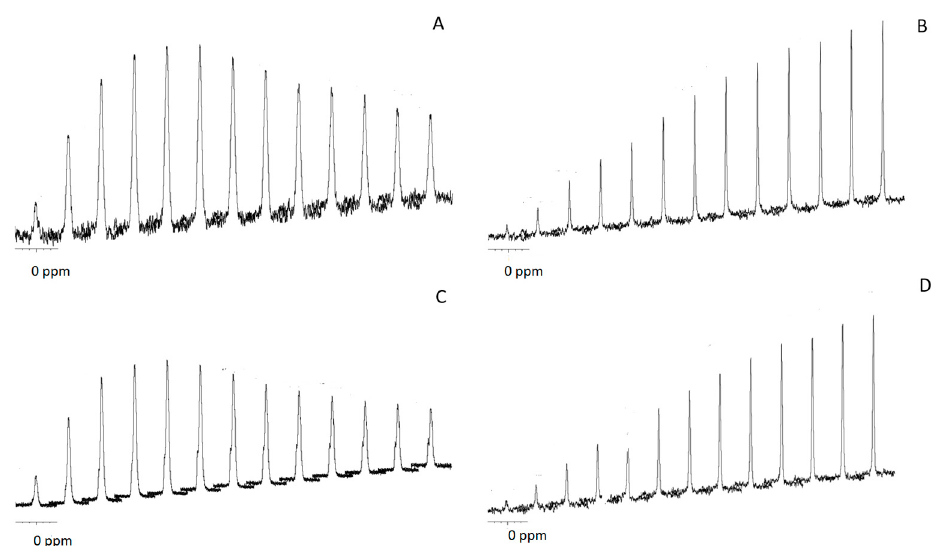
Figure 5. Array of CP spectra at different contact times for CSCaP1 ( A ); CSCaP1C ( B ); CSCaP3 ( C ) and CSCaP3C ( D ). From left to right contact times: 0.1, 0.5, 1, 1.5, 2, 3, 4, 5, 6, 7, 8, 9 and 10 ms.